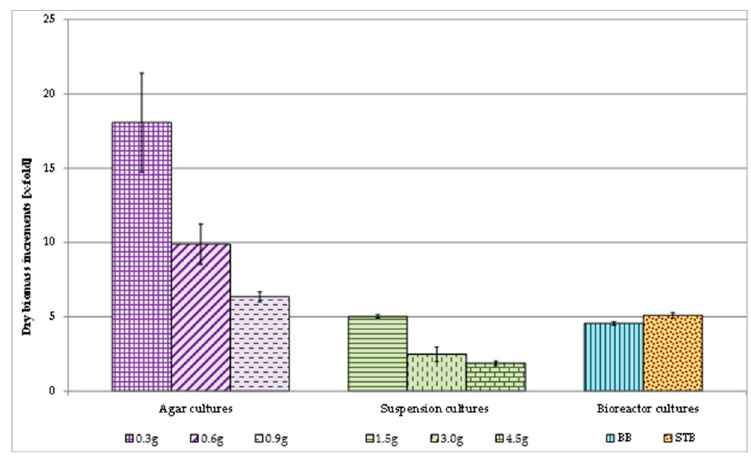
Figure 2. Dry biomass increments of V. officinalis in vitro cultures. Table 1. Phenylpropanoid glycosides accumulation (mg / 100 g DW ± SD) and their specific